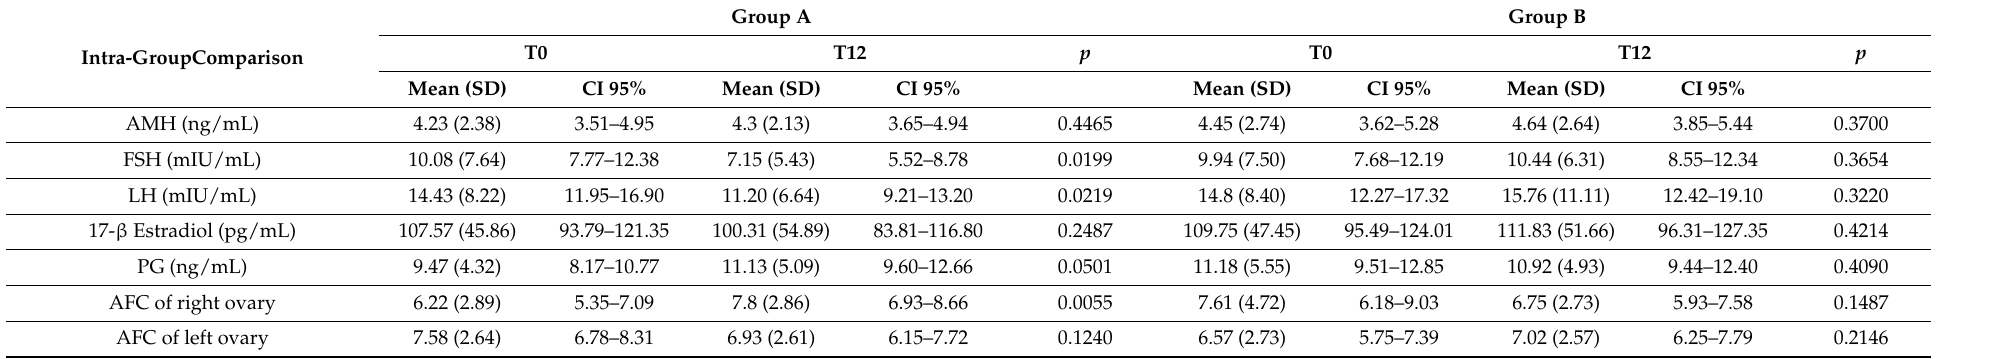
Table 1. Comparison of ovarian function parameters in long-term survivors of lymphoma between baseline (T0) and after 12 months of oral supplementation with Myo-Inositol and D-Chiro-Inositol combined therapy (T12; Group A) and between baseline (T0) and after 12 months of follow-up without any nutritional supplement (T12; Group B).